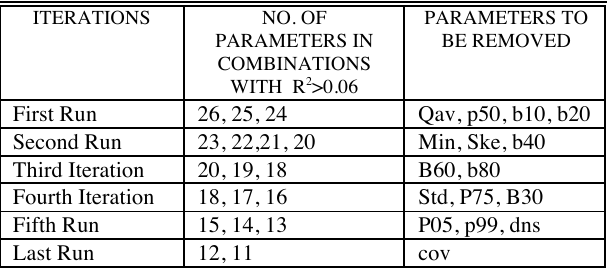
Table 3: List of Parameters Removed from LiDAR Combinations